Question: Write a caption explaining this figure to a reader.
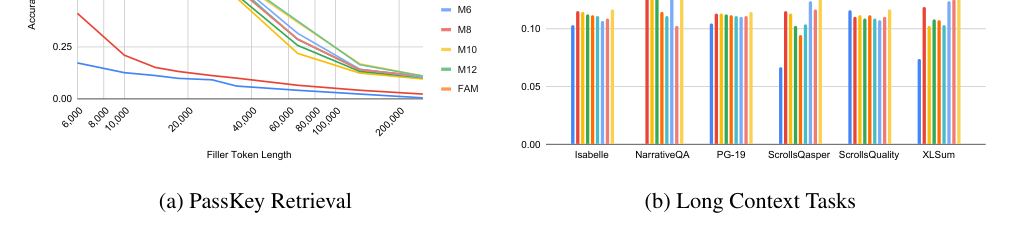
Answer: (a) PassKey Retrieval: Performance across different Transformer models and memory segment configurations. MX denotes the number of BSWA memory segments. FAM represents TransformerFAM with 0 memory segments. TransformerFAM successfully solves the task. (b) LCT: Normalized scores of long-context tasks evaluated by Flan 1B with different Transformer models and different memory segment configurations. FAM outperforms all other BSWA configurations.